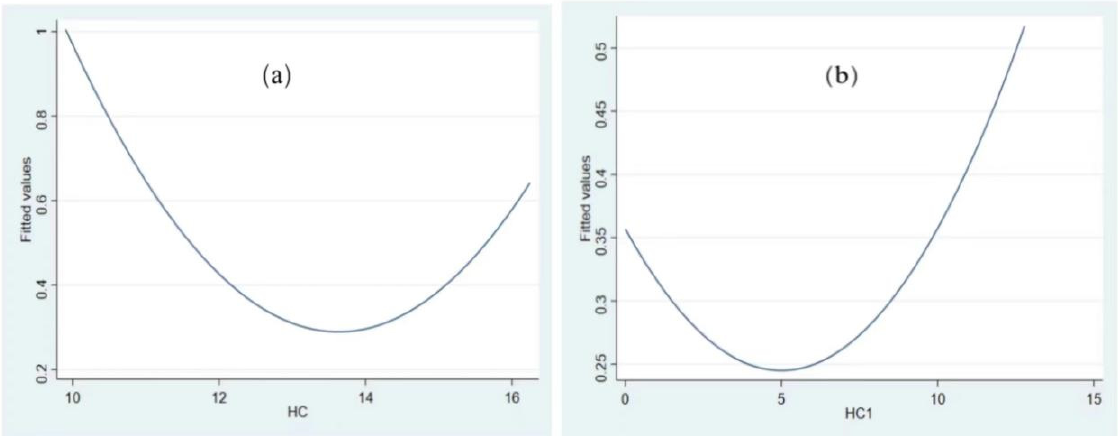
Figure 4. Fitting diagram of U-shaped relationship between HC and GEE, ( a ) fitting diagram of HC Fitting diagram of U-shaped relationship between HC and GEE, ( a ) fitting dia- and GEE (HC = education expenditure) ( b ) fitting diagram of HC 1 and GEE(HC 1 = years of educa- gram of HC and GEE (HC = education expenditure) ( b ) fitting diagram of HC 1 and GEE tion). (HC 1 = years of